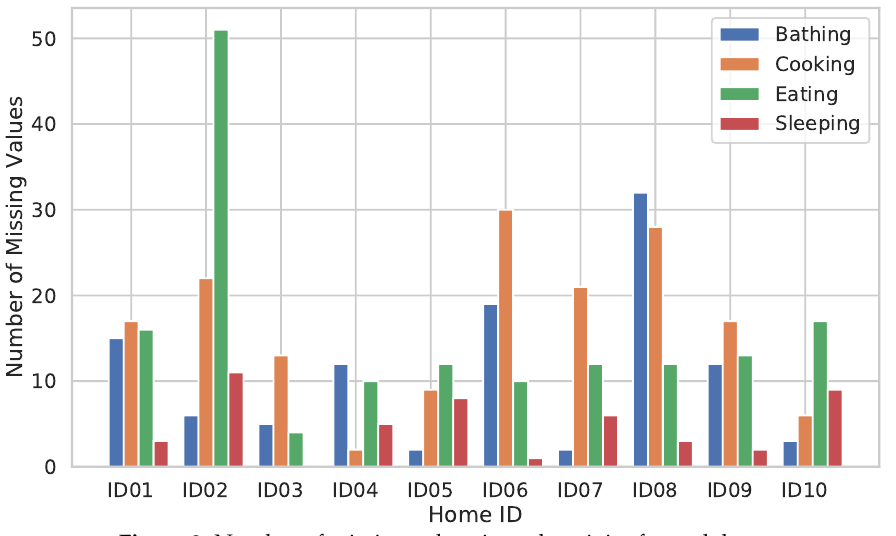
Figure 9. Number of missing values in each activity for each home. Table 3. Ratio of increase in activity duration by